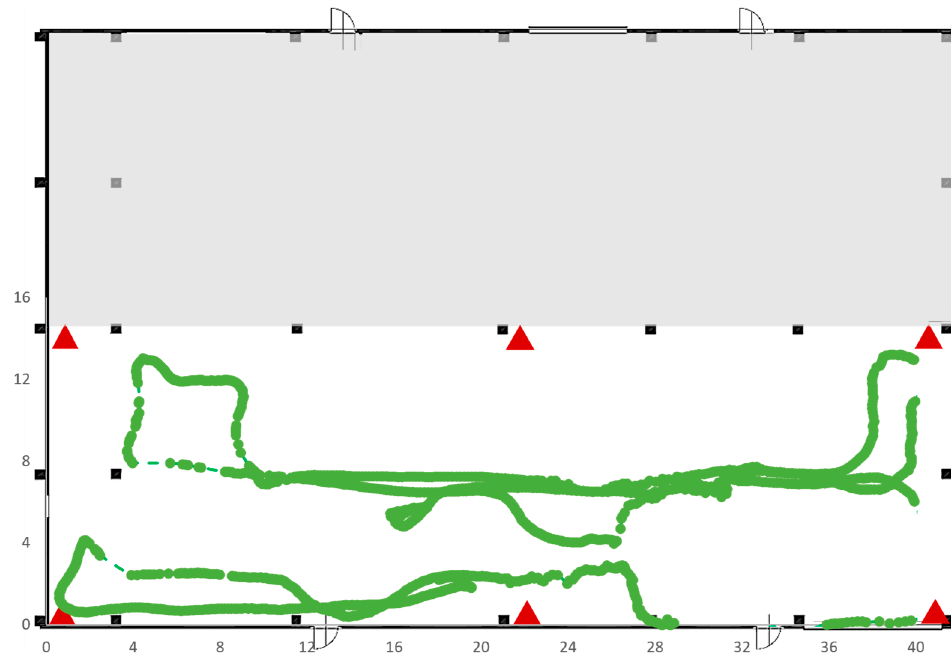
Figure 23. Different positions of the tag in Test 6: High-Tag (green), Mid-Tag (red) and Low-Tag (blue).